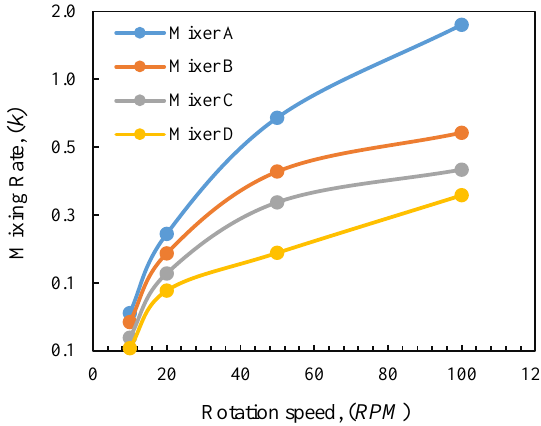
Fig.4 : The relationship between the mixing rate and mixer sizes at a different rotation speed.